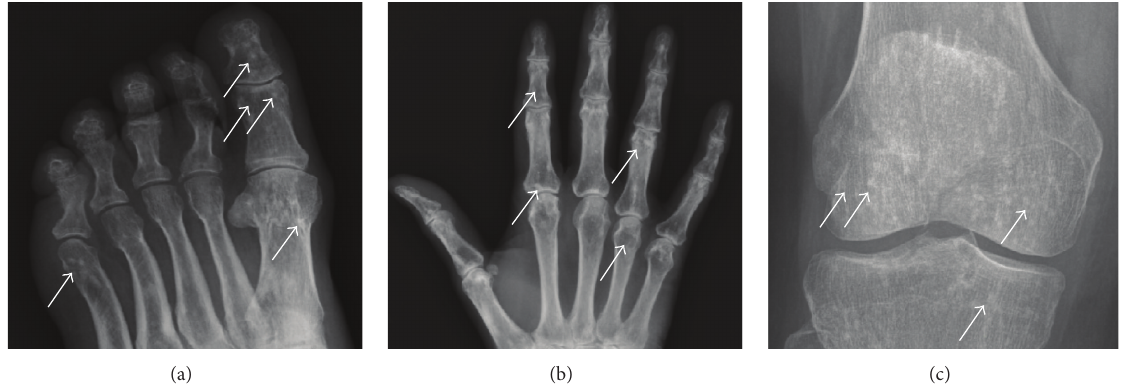
Figure 3: Osteopoikilosis. Plain radiographs. (a) Foot. (b) Hand. (c) Knee. Note multiple small (1–5 mm) sclerotic periarticular lesions consistent with bony islands of osteopoikolosis (marked by